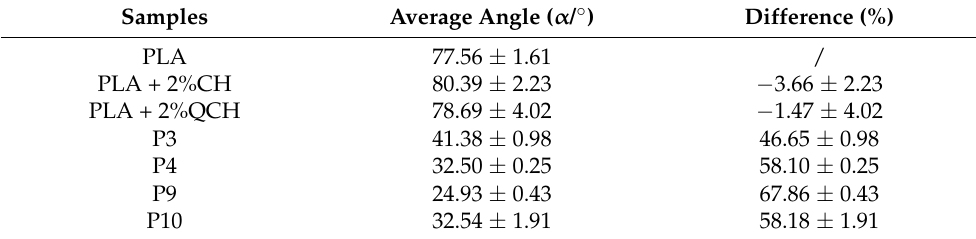
Table 5. Contact angles for PLA, reference samples, and P3, P4, P9, and